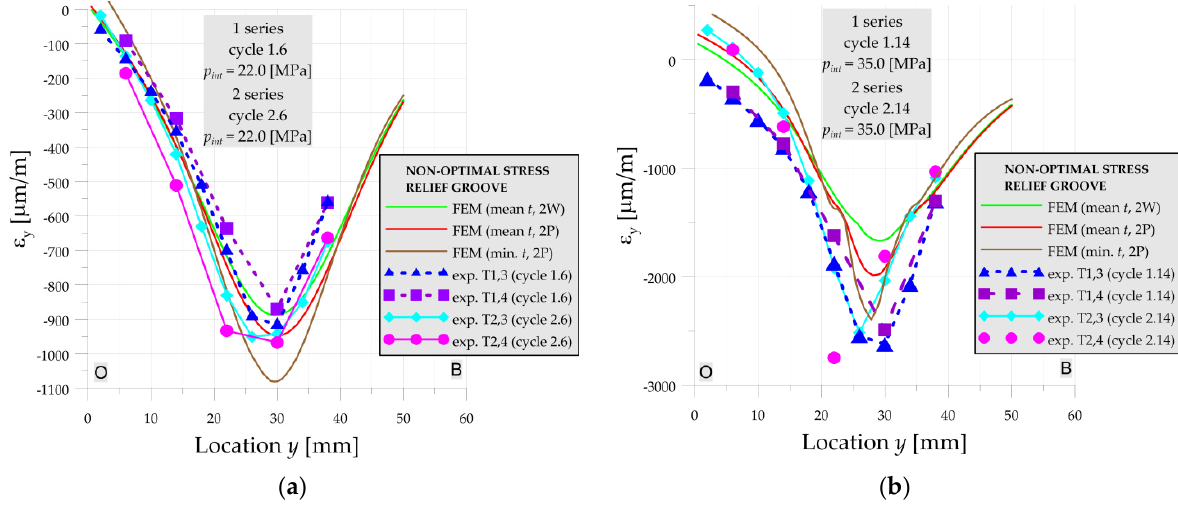
Figure 13. Numerical and experimental strains on line O-B, non-optimal SRG, 1st and 2nd series: ( a ) cycles 6; ( b ) cycle 14.